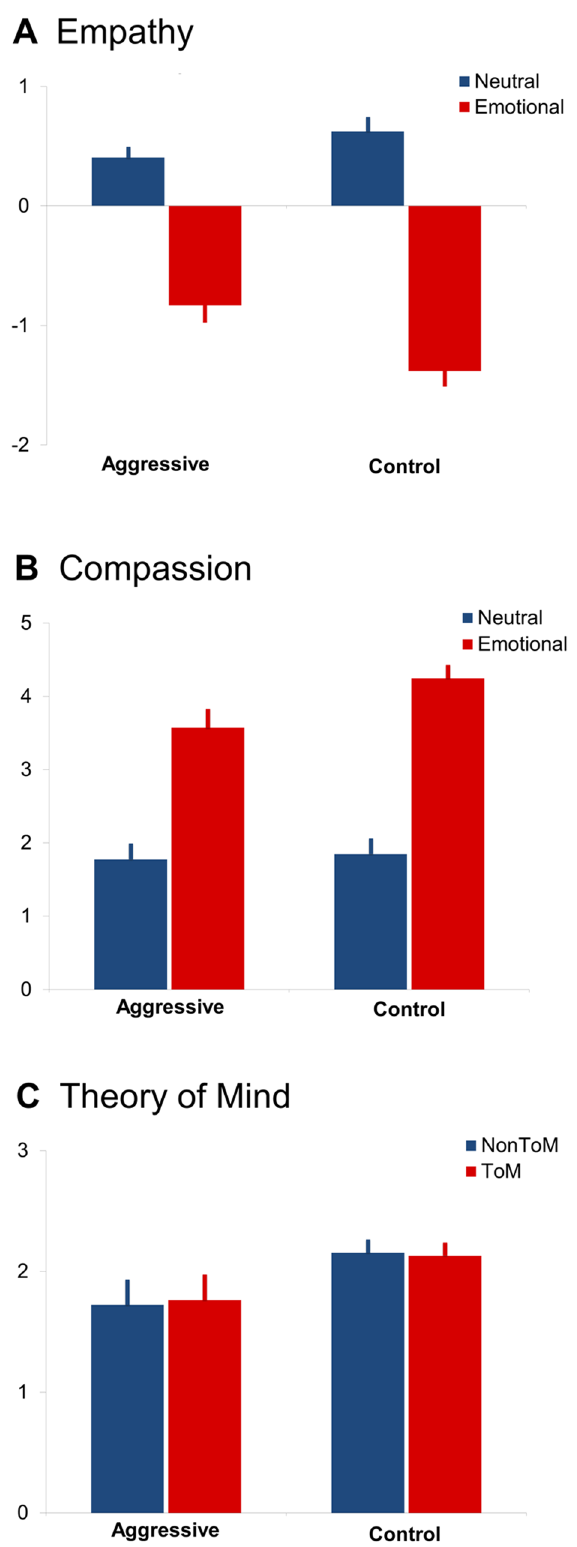
Figure 2. EmpaToM ratings and performance: ( A ) empathy ratings (emotional and neutral condition), ( B ) compassion ratings (emotional and neutral condition), and ( C ) ToM and factual reasoning performance (composite score of error rates and reaction time ratings, performance scores were z-transformed and for display purpose depicted with a mean of 2) for the aggressive and the control group. Error bars represent 95% confidence